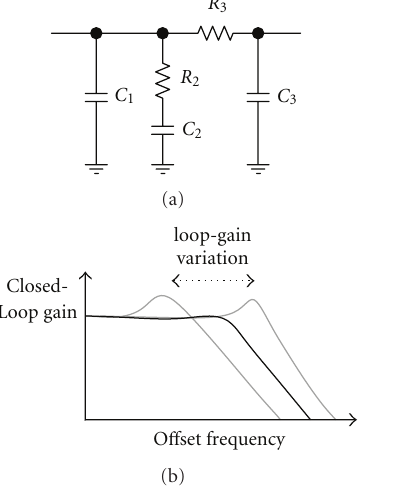
Figure 7: (a) A third-order passive loop filter. (b) Closed-loop gain and bandwidth variation in PLL.